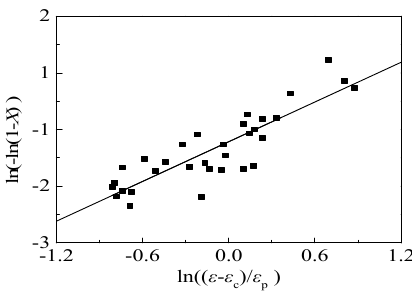
Figure 5. Dependence of ln(–ln(1 – X ( ε ))) with ln( ε – ε c )/ ε p .